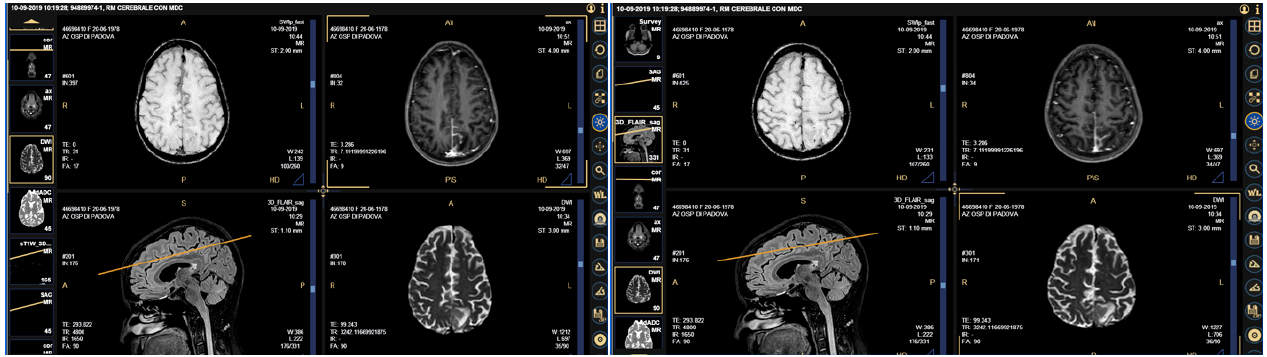
Figure 1. Cerebral MRI (Magnetic Resonance Imaging) highlighting the presence of leptomeningeal metastases at the bottom of the right central sulcus, on the surface of the convolutions of the left pre-wedge, with associated edema of the underlying parenchyma.